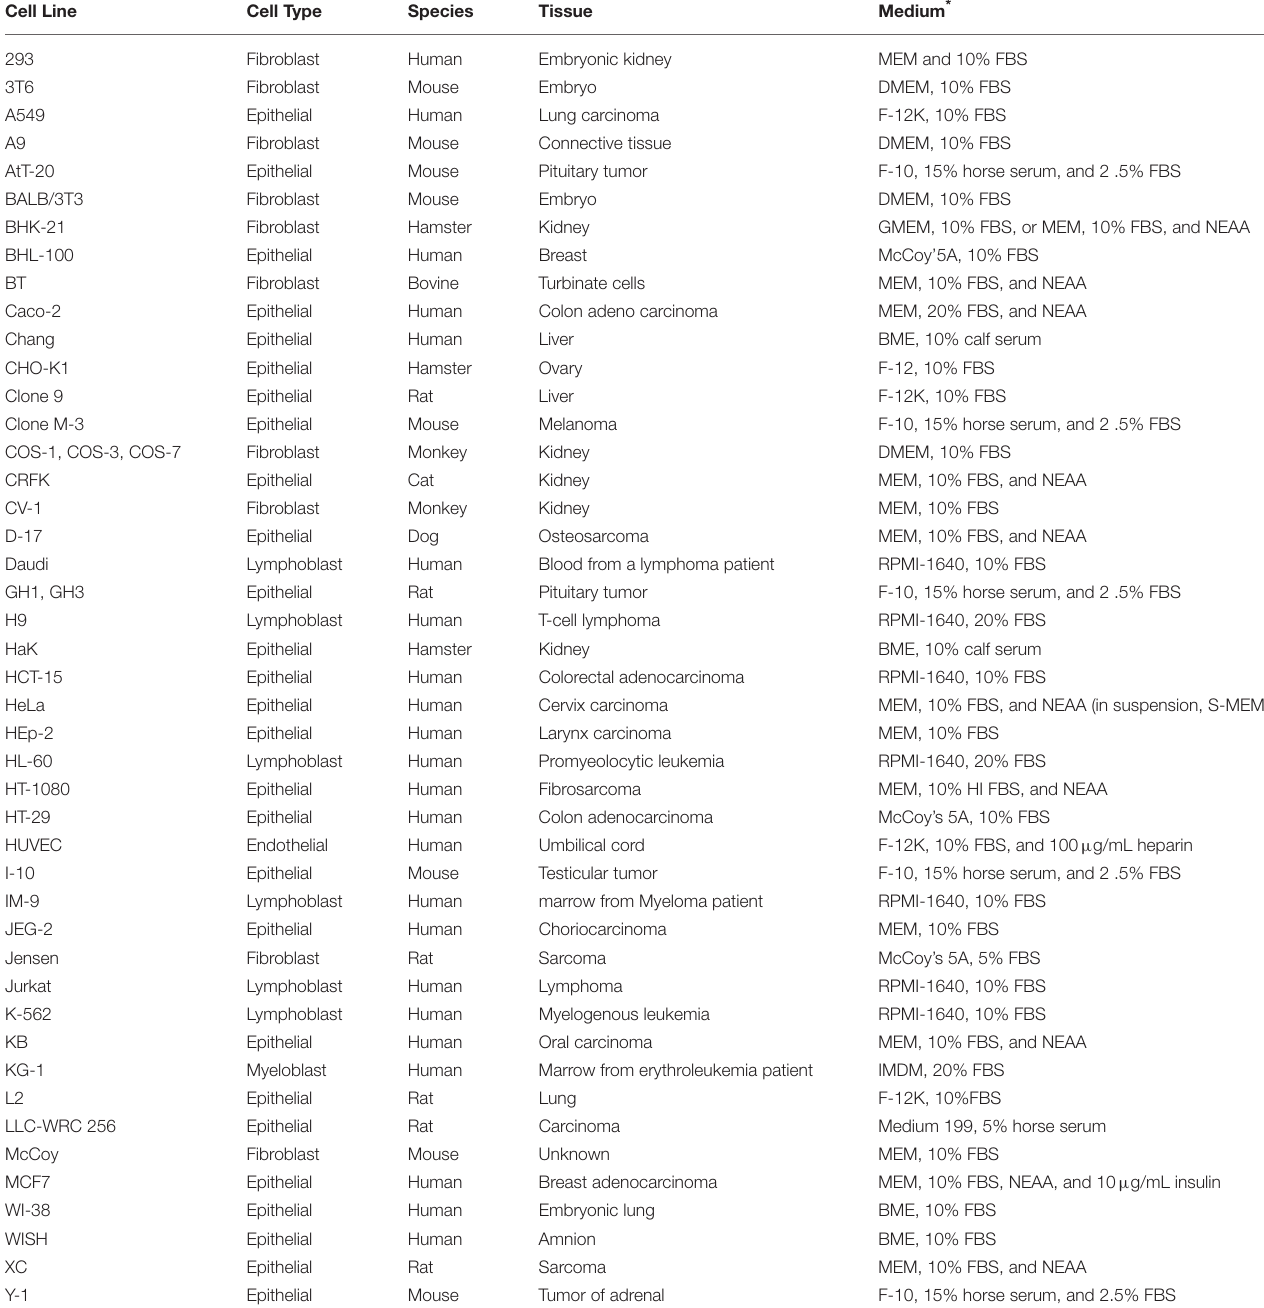
TABLE 1 | Mammalian cell lines and culture